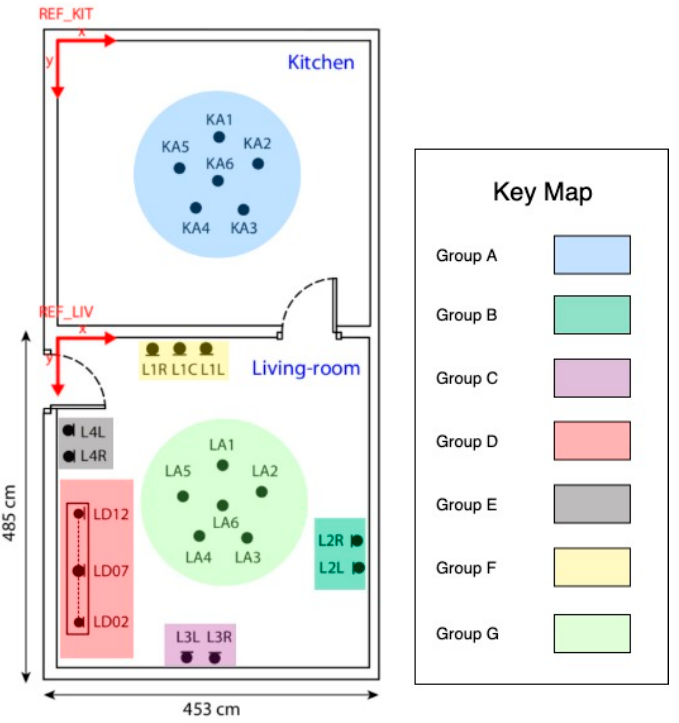
Figure 4. Groups of microphones for the evaluation